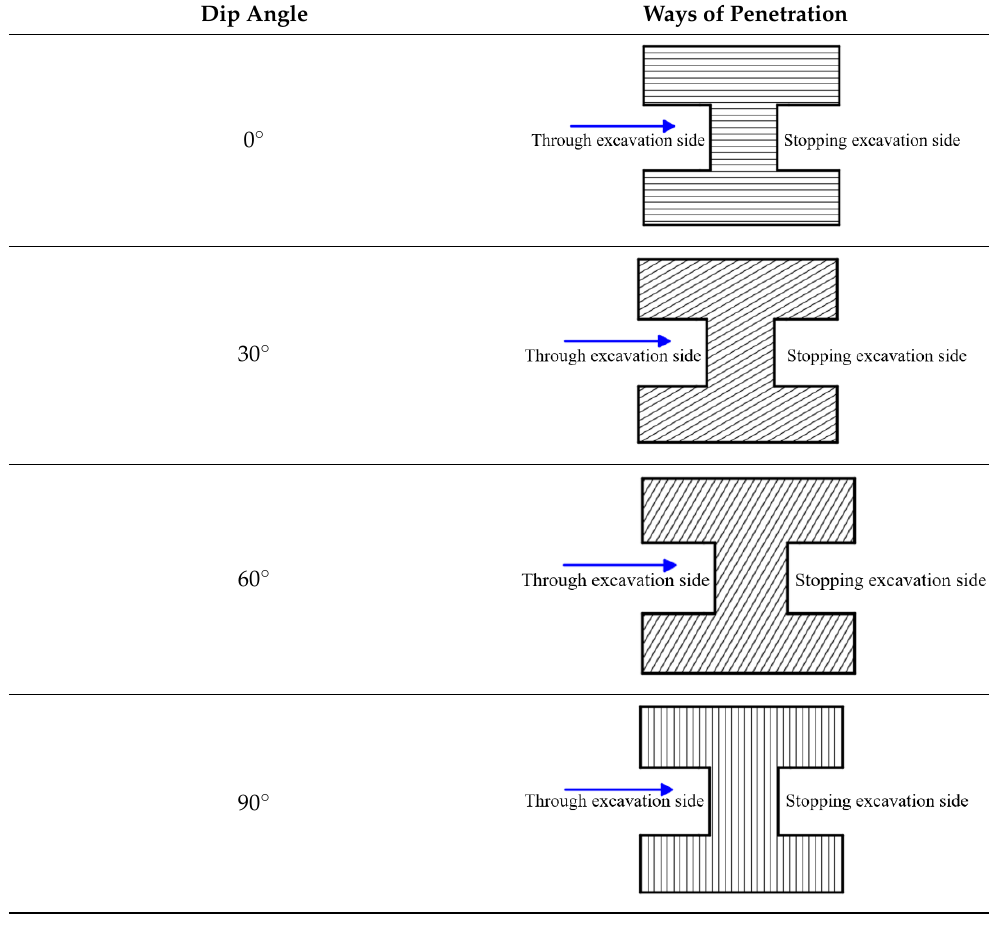
Table 4. Cumulative vault settlement from the cross-section of the tunnel under the influence of different inclination angles.